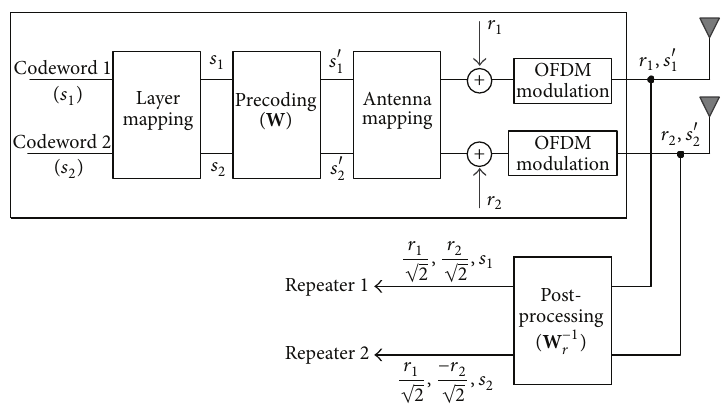
Figure 2: Proposed architecture supporting 3G